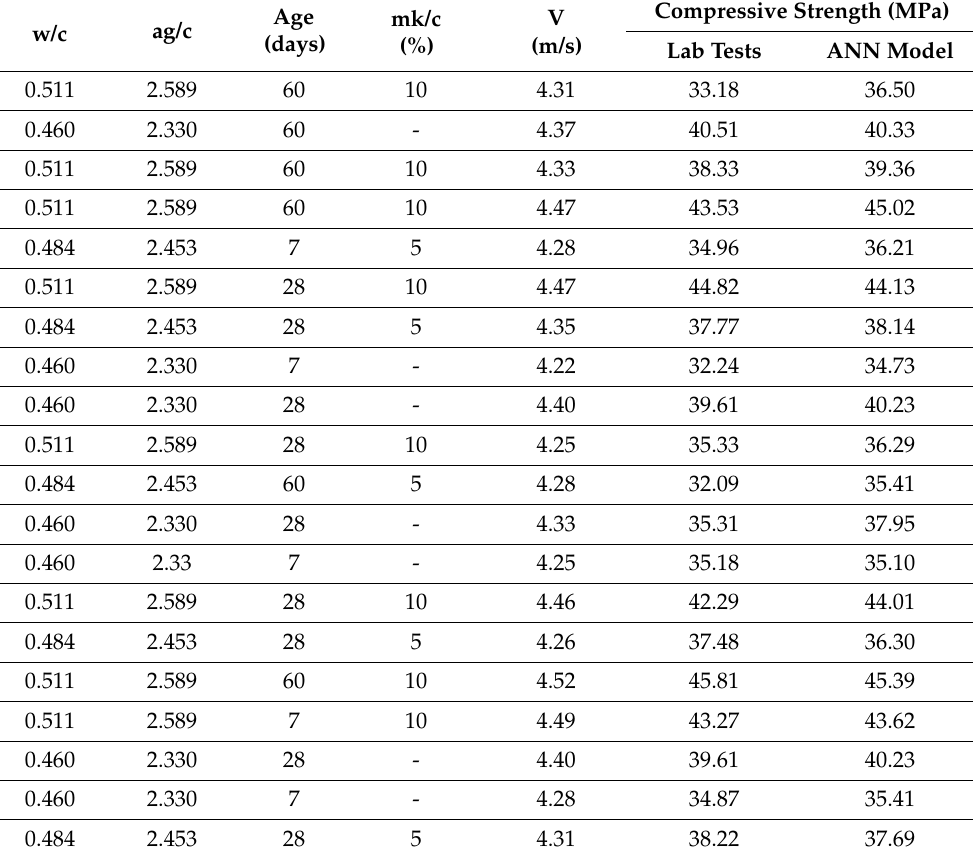
Table 4. Comparison between targets and ANN outputs.